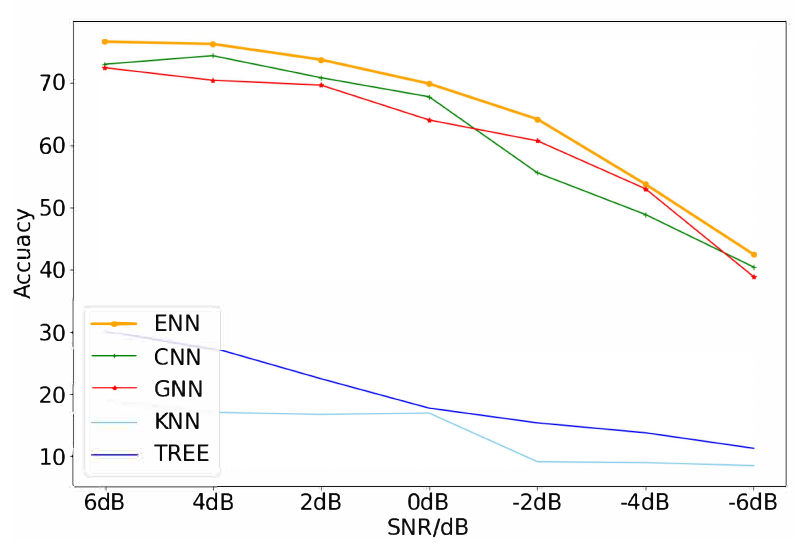
Figure 6. Accuracies of the proposed method and the comparison methods at various